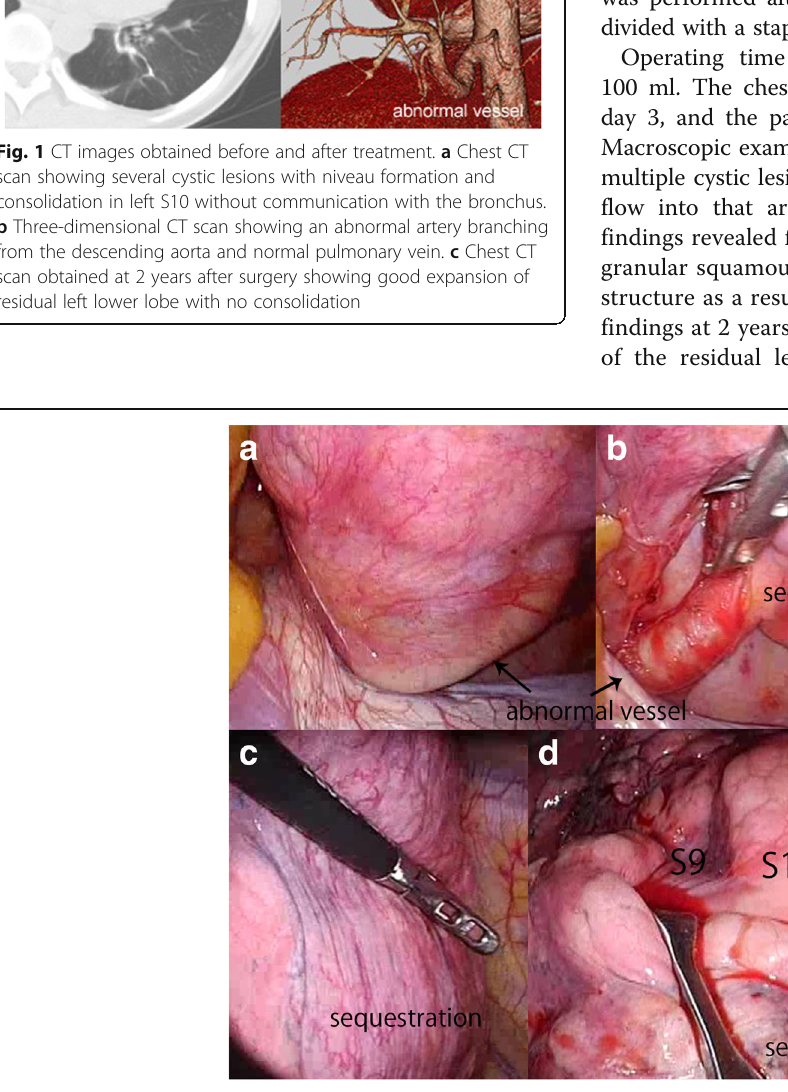
Fig. 2 Intraoperative findings. a The abnormal artery was inside the lung ligament b branching from the descending aorta. c The sequestration had a dark red appearance due to developed capillary vessel of visceral pleura. d The sequestration portion was completely included in S10. The boundary line was clearly revealed with inflation of the lung after cutting